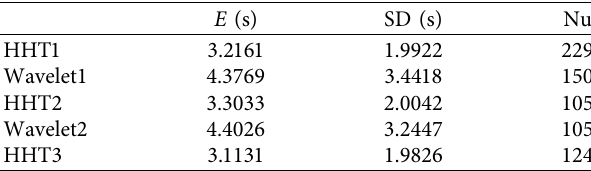
Figure 22: The period comparison of common velocity pulses. Table 7: Statistical parameters of the pulse